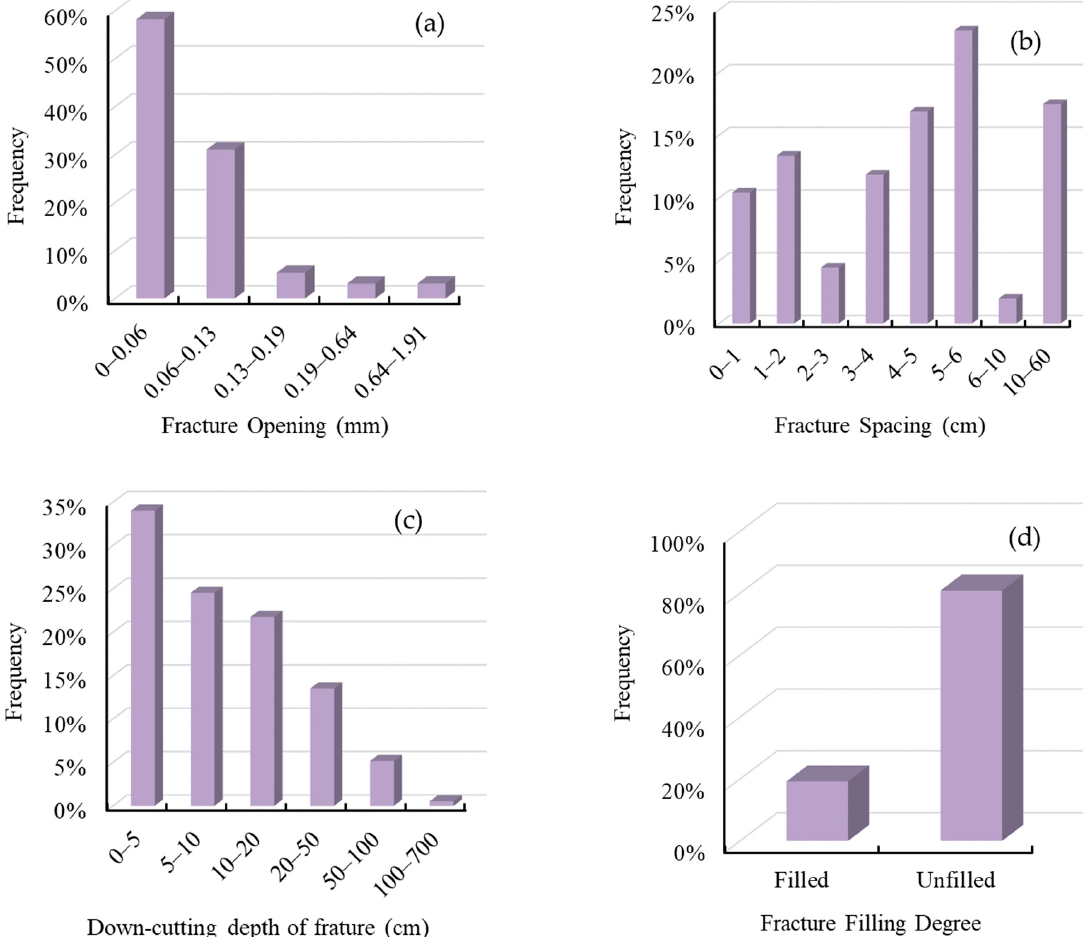
Figure 7. Histogram of fracture development effectiveness parameters ( a ) fracture opening, ( b ) fracture spacing, ( c ) fracture down-cutting depth, ( d ) fracture filling